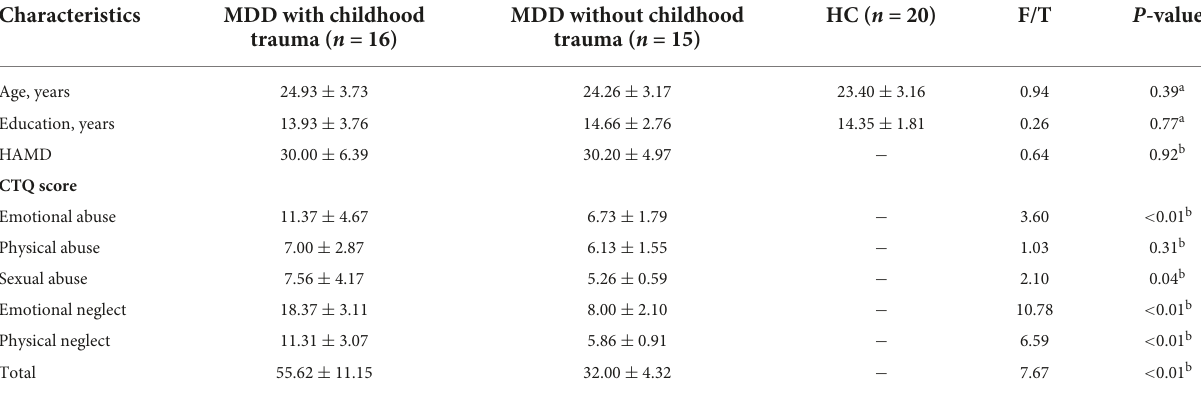
TABLE 1 Characteristics of MDD with childhood trauma, MDD without childhood trauma, and HC groups. Characteristics